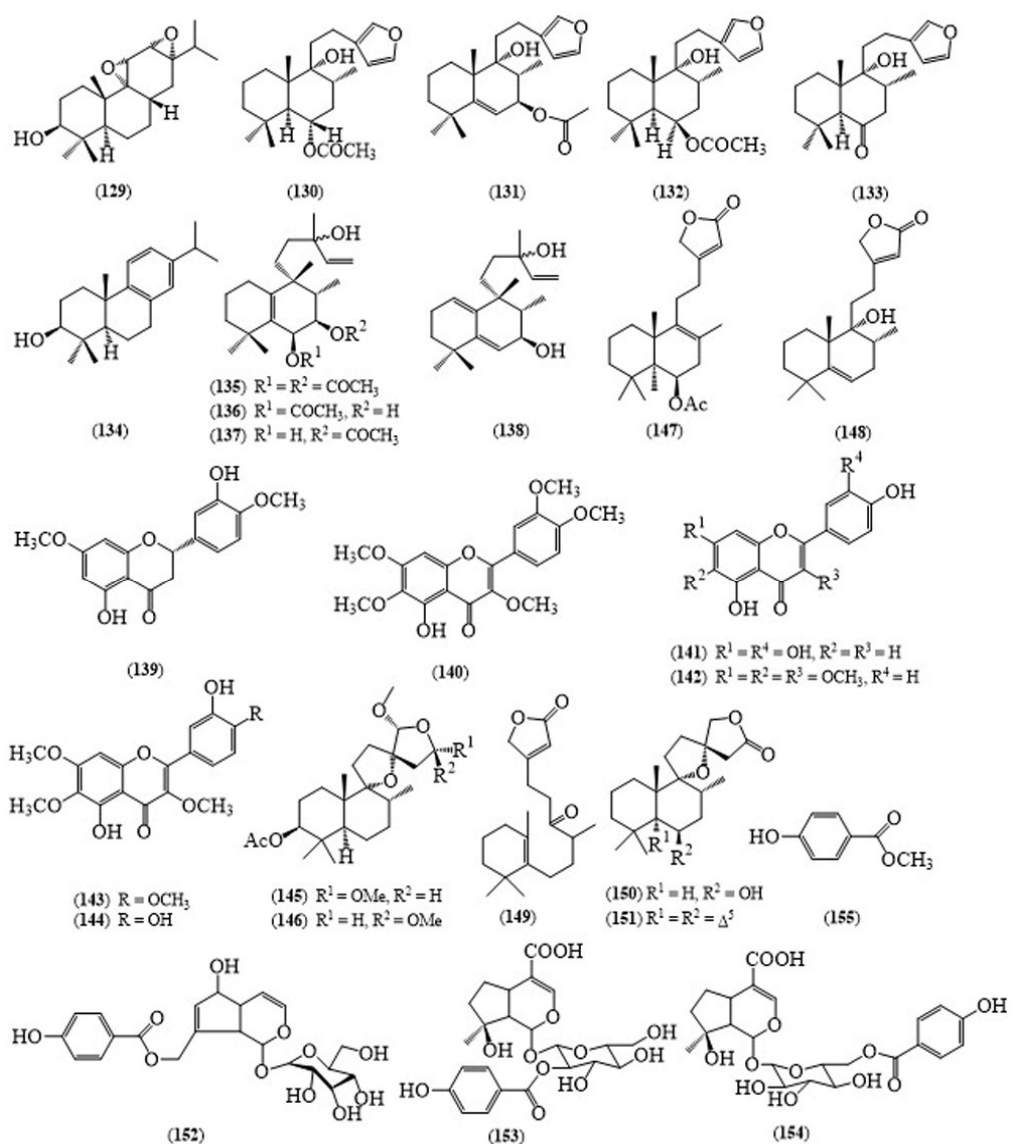
Figure 12. Structures of selected compounds isolated from Vitex trifolia.